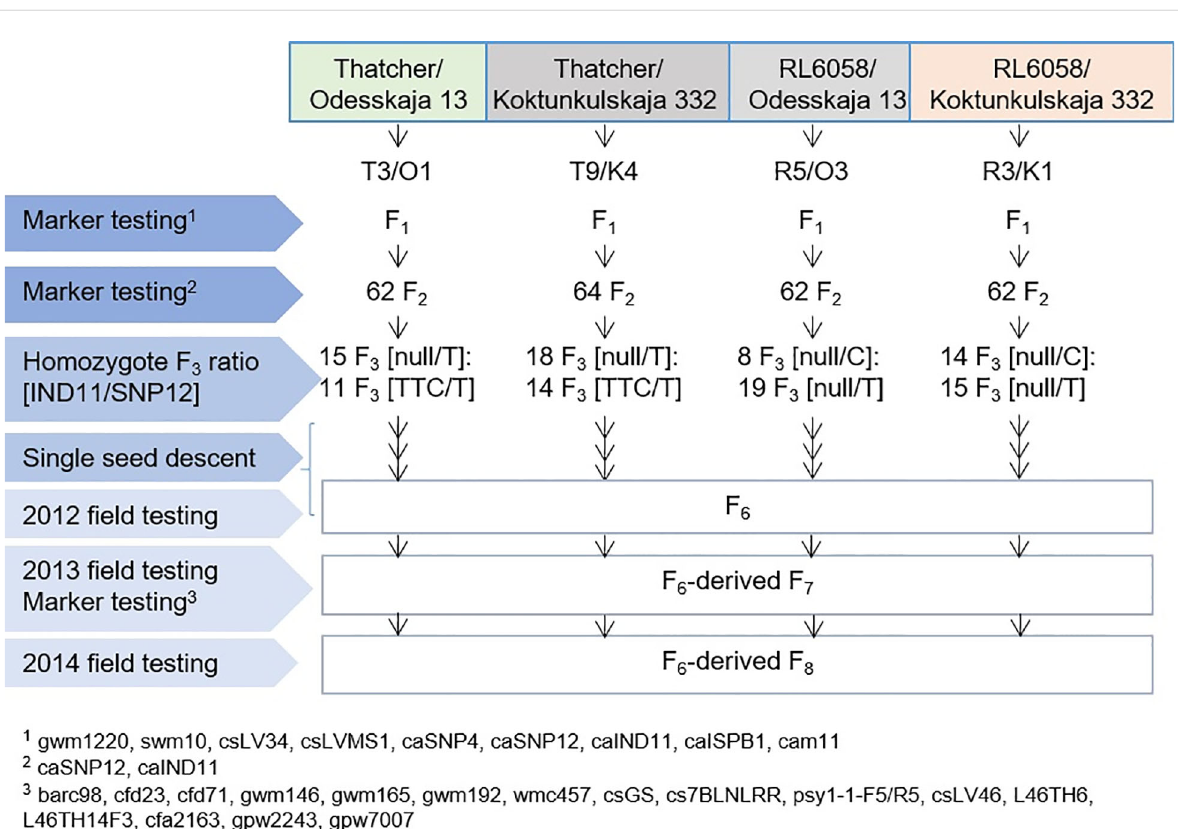
FIGURE 1 Description of the four populations developed to determine the role of the Lr34 mutations in exons 11 and 12. Generations tested with molecular markers and phenotypically assessed in the fi eld for severity of leaf rust infection are identi fi